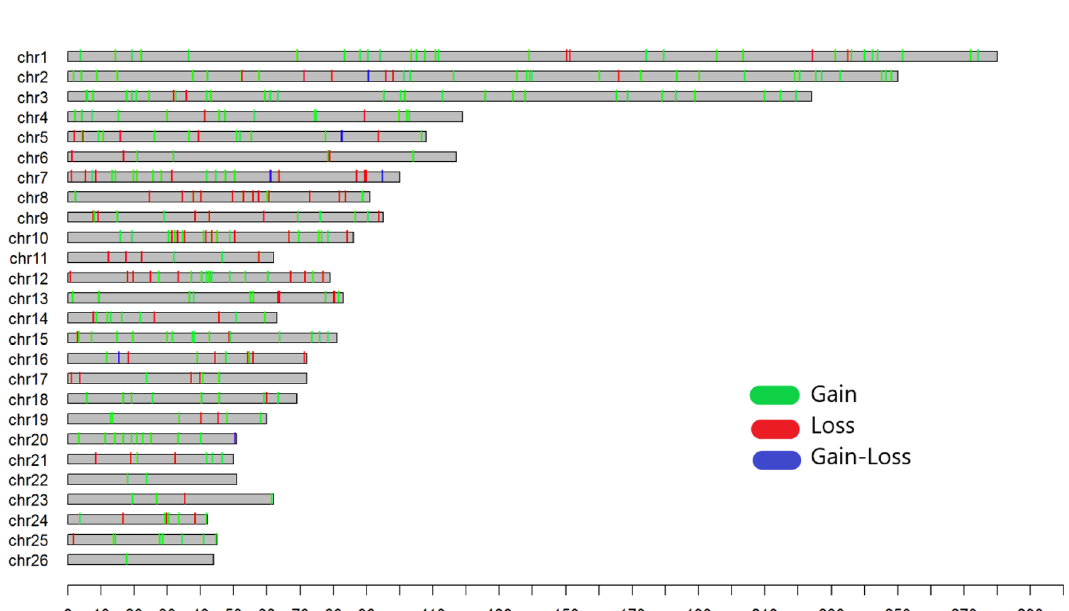
Figure 2. Chromosomal distribution of copy number variant regions (CNVRs) in Afghan sheep breeds, developed using R v4.0.2 (https:// cloud.r- proje ct. org/): in this figure the chromosome length (Mb) is displayed on the X-axis and CNVR variations with deletion, duplication, and deletion/duplication state showed on different chromosomes on